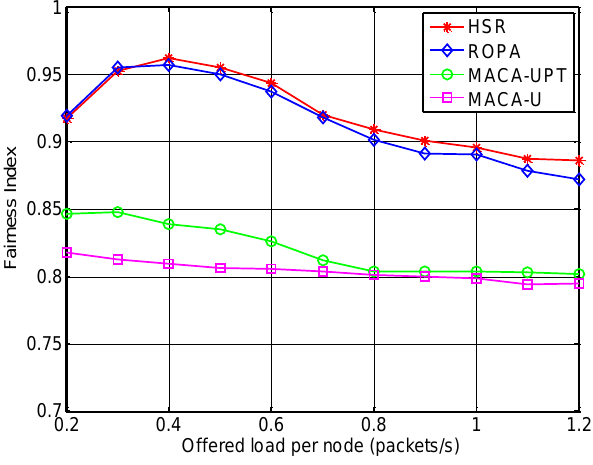
Figure 14. Fairness index for HSR compared with other MAC